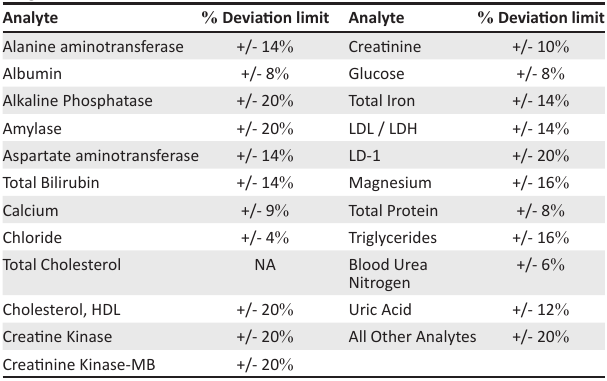
TABLE 1: Reference range verification tolerance limits according to Sigma